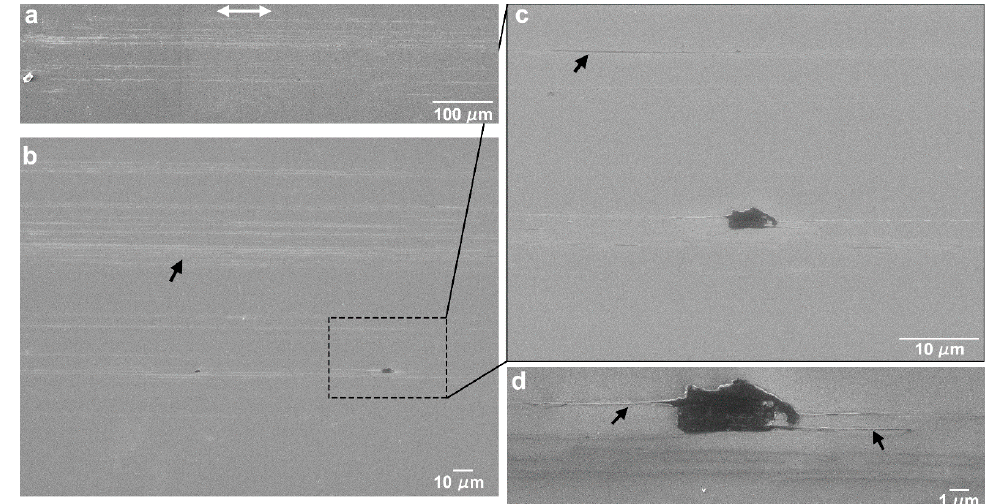
Figure 5. SEM micrographs of the centre of wear tracks on polished Si specimen performed at 5 mN. ( a , b ) General view of the wear track at di ff erent magnifications. ( c ) Transferred PTFE material. ( d ) Detailed view of the transferred PTFE material. The double arrow indicates the sliding